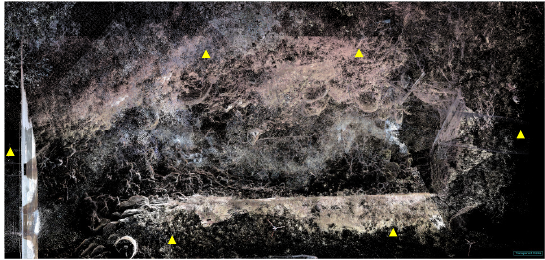
Figure 3. TLS data of study section. Check dam locates in the left side of the figure and triangles show scanner locations.